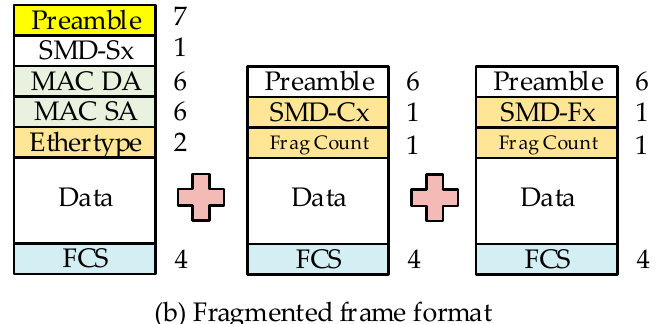
Table 2 . Fragmented frame identifier.